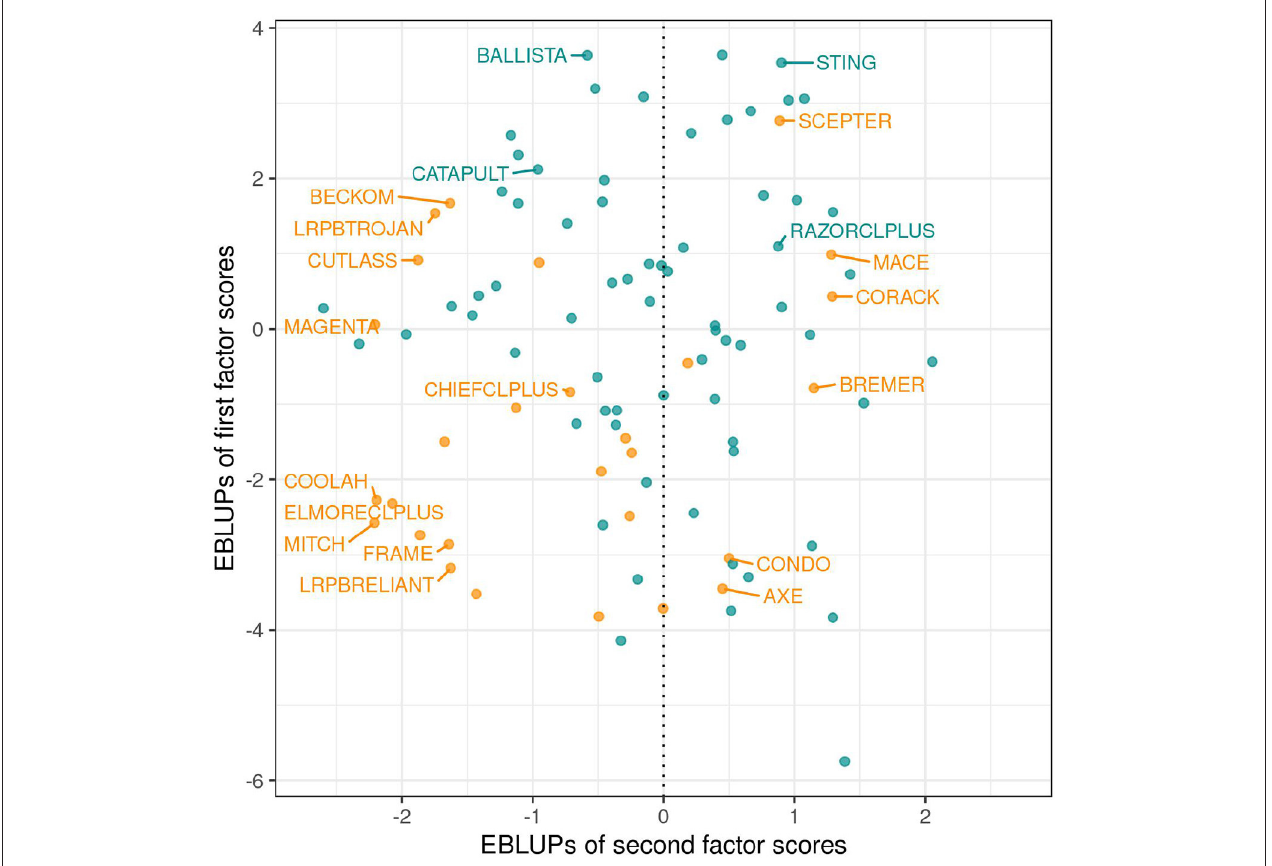
FIGURE 3 | EBLUPs of first and second factor scores for the 96 varieties of interest. Points and labels are colored orange (check varieties) or blue (test varieties). Selected check varieties have been labeled as have four test varieties that have since been released commercially.